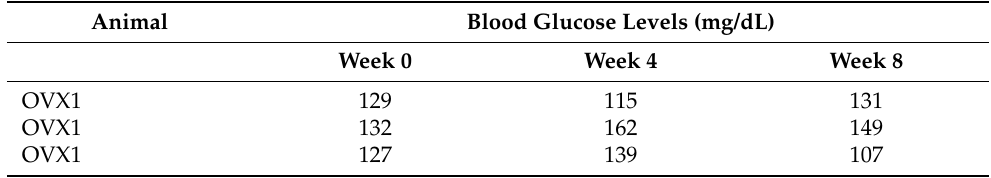
Table 3. Blood glucose levels over 8 weeks determined for the OVX animals. Animal